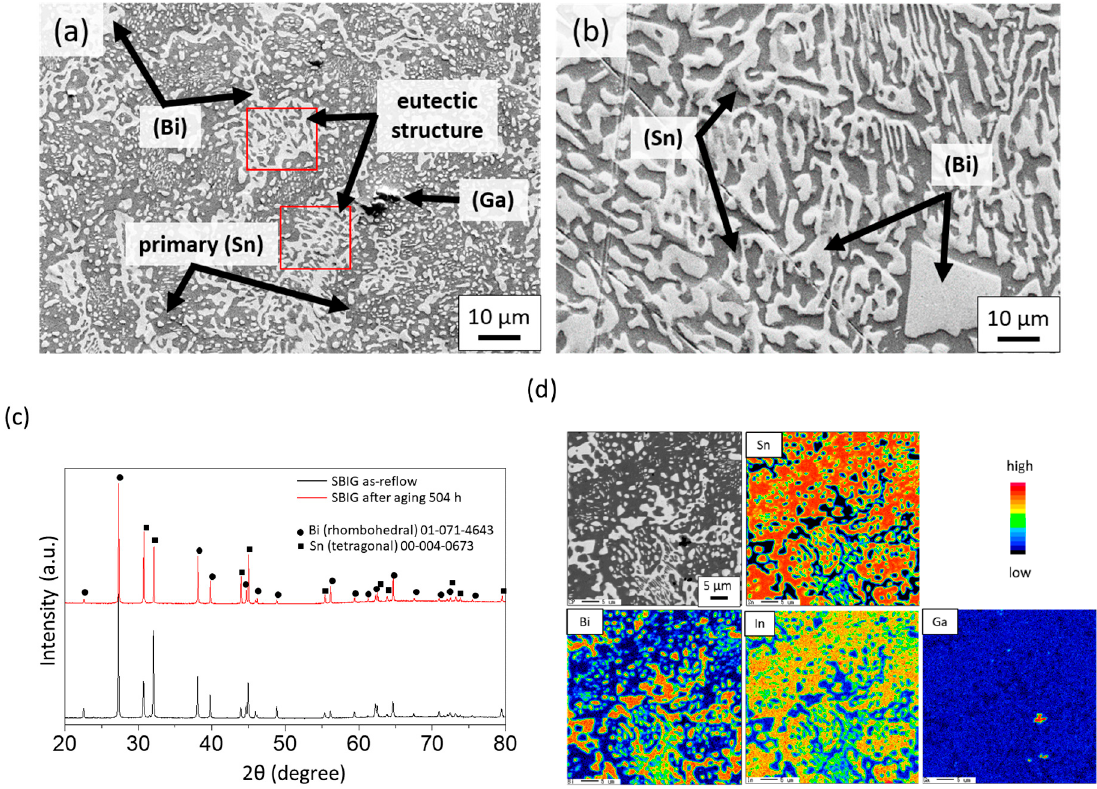
Figure 4. The field-emission scanning electing microscope (FE-SEM) images of ( a ) as-cast SBIG and ( b ) as-cast Sn–58Bi alloys. ( c ) The XRD patterns of as-cast and 80 °C and 504 h-aged SBIG alloys. ( d ) The field-emission electron probe micro-analyzer (FE-EMPA) elemental mappings of the as-cast SBIG alloy.